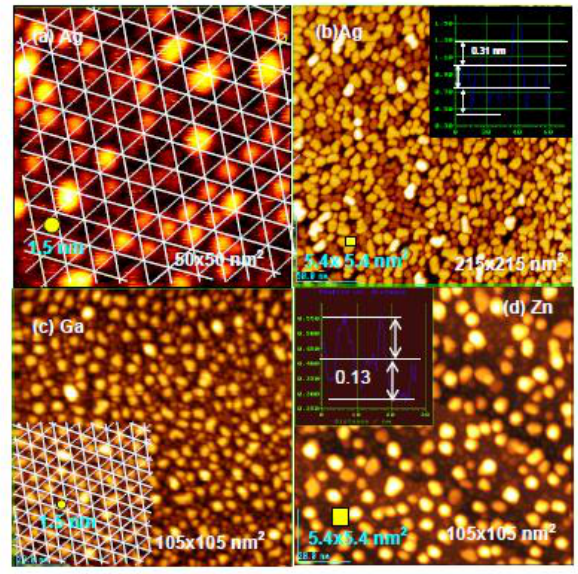
Figure 21. Controlled growth of nano-dots on the Si(111)-7 × 7 C Growth of Ag-dots from a sing Ag atoms; ( b ) Growth of Ag-dots into 5 nm crystalline dots. The dots have a similar size as hexagonal mesh (5.4 × 5.4 nm 2 ); ( c ) Ga-dots seem to grow in a half unit cells; ( d ) The growth of nano-crystalline Zn-dots may be regulated by a hexagonal mesh. Yellow square indicates the size of 5.4 nm 2 [71].